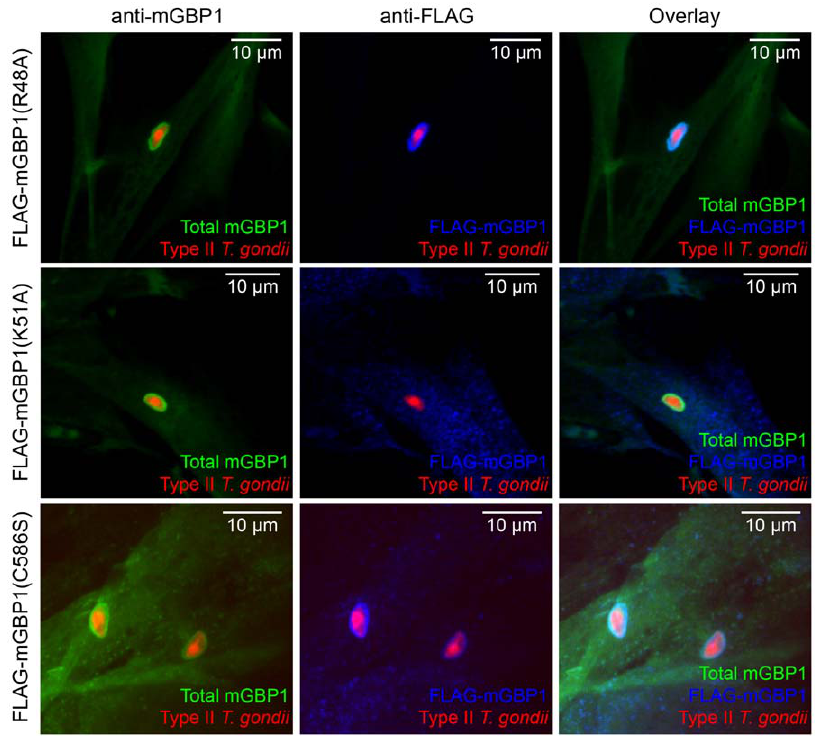
Figure 3. Nucleotide-dependent multimerization is required while farnesylation is dispensable for recruitment of mGBP1 to the PV. (A) Confocal pictures show MEFs that overexpress FLAG-tagged mutants of mGBP1 stimulated with 200 U/ml IFN- c overnight and infected with mCherry-expressing type II T. gondii (Pru) at an MOI between 5 and 10 for 1 h. The R48A and C586S mGBP1 mutants were targeted to the PV like the wild-type counterpart. In contrast, the K51A mGBP1 mutant was unable to accumulate around the PV. Rabbit polyclonal anti-mGBP1 antiserum and a mouse monoclonal anti-FLAG antibody were used for stainings.